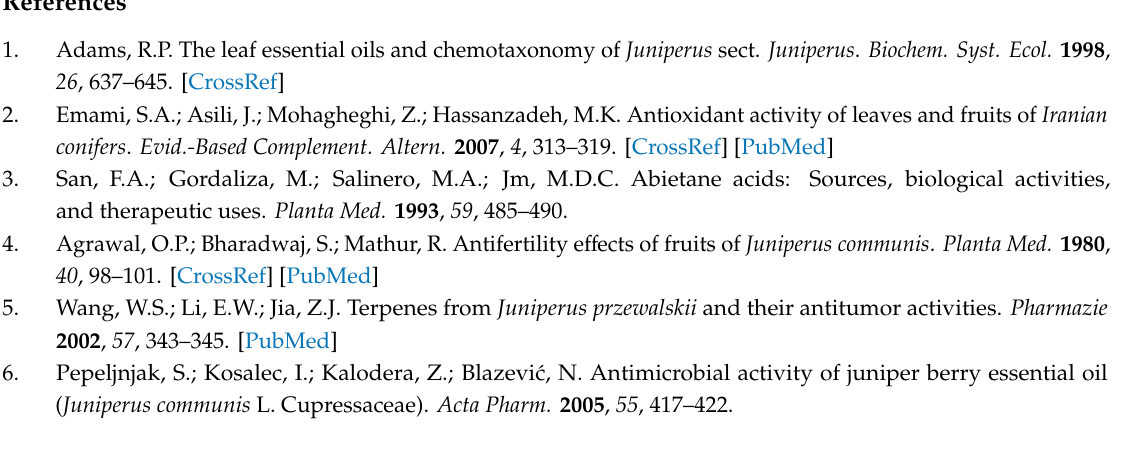
Supplementary Materials: The following are available online: NMR, MS data of compound 1 , data of ECD calculation for compound 1 , single crystal X-ray di ff raction data and refinement parameters with bond lengths and bond angles of compound 3 and 6 . IC 50 valves of selected